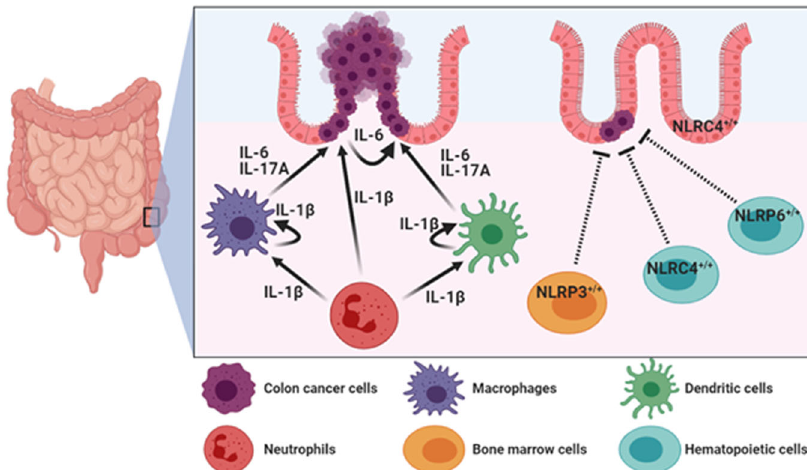
Fig. 4 Mechanisms of CRC regulation mediated by extrinsic in fl ammasome activation. In colorectal tumor microenvironment, IL-1 β derived from in fi ltrated neutrophils, macrophages, and dendritic cells enhances CRC progression through production of IL-6 and IL-17A from lamina propria, macrophages, and dendritic cells. On the other hand, NLRP3 in bone marrow cells, NLRC4 and NLRC6 in hematopoietic cells, and NLRC4 in colon epithelial cells play tumor suppressive roles in CAC